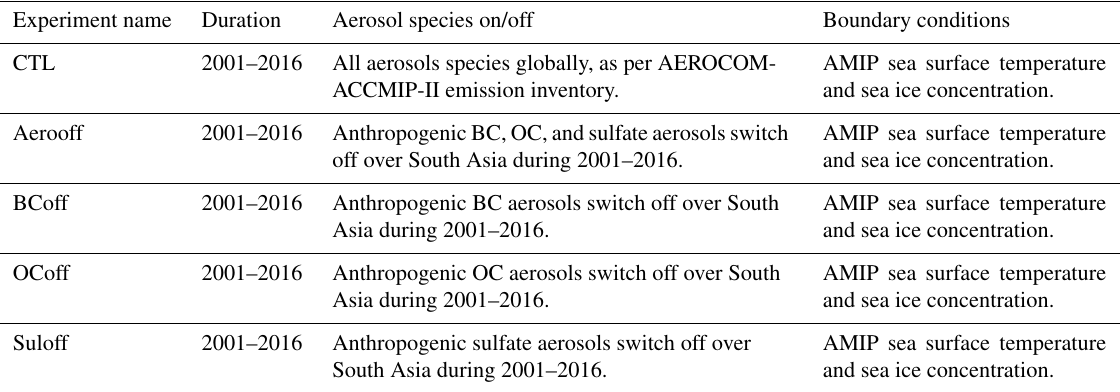
Table 1. Details of ECHAM6-HAMMOZ model simulations performed in this